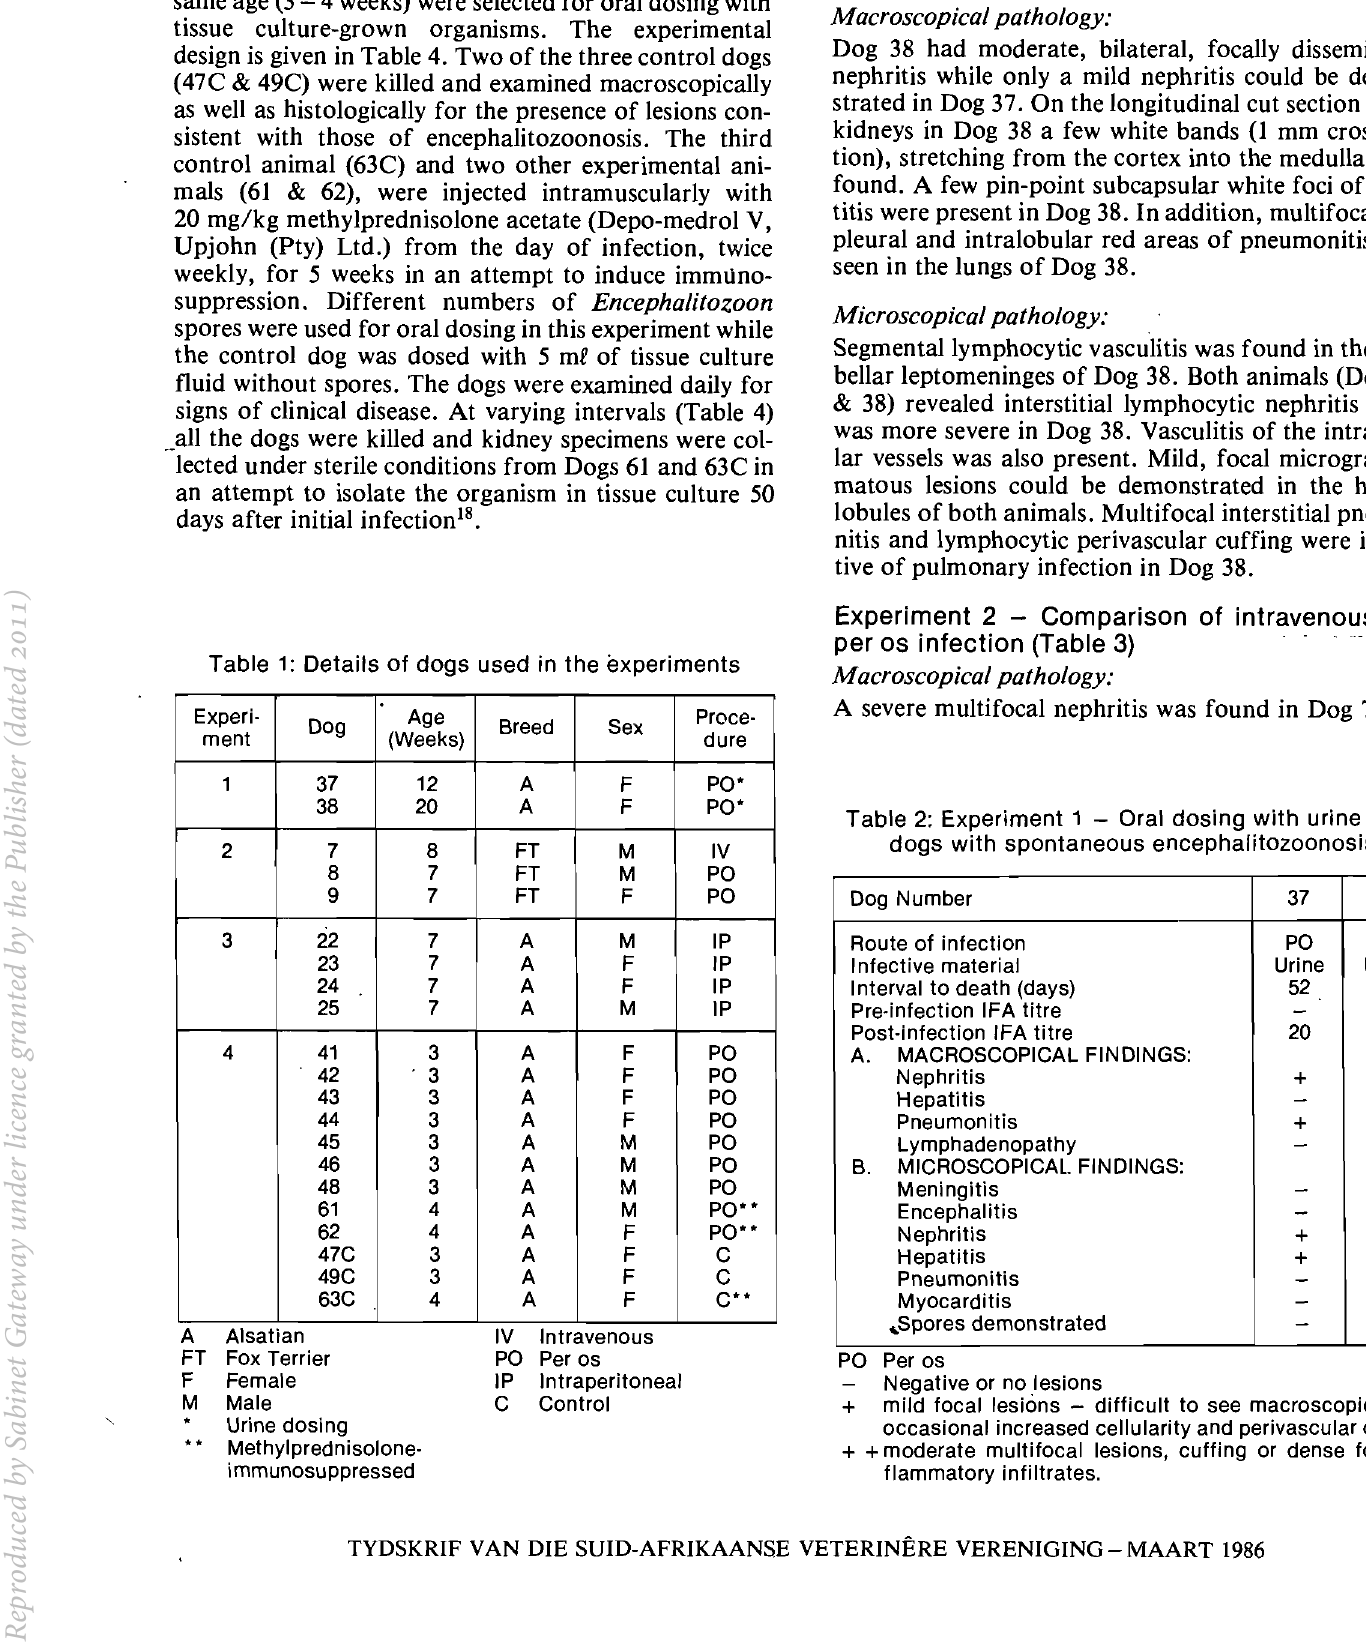
Table 1: Details of dogs used in the experiments Experi- Dog